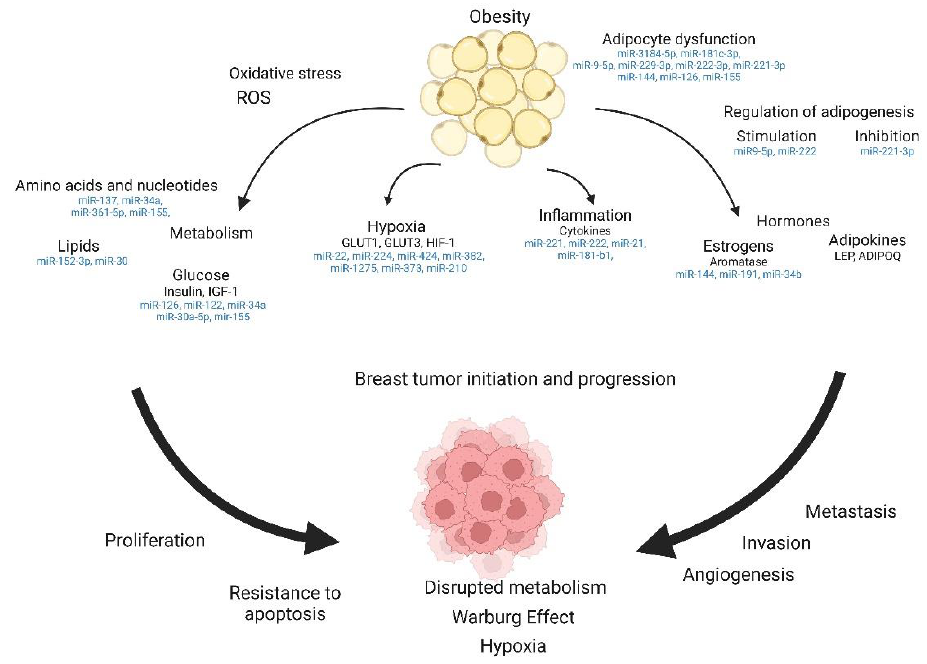
Figure 3. Obesity-related breast tumor initiation. The above figure was created with BioRender.com. Agreement number: KP24PM3RRF.